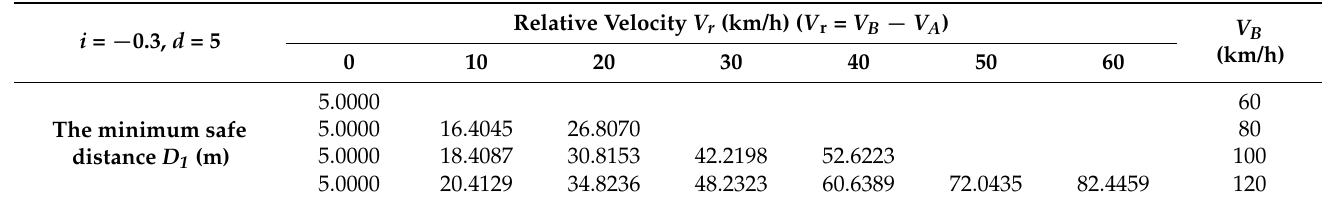
Table 8. The minimum safe distance D 1 based on V B between 60 and 120 km/h when i = − 0.3 and d = 5.